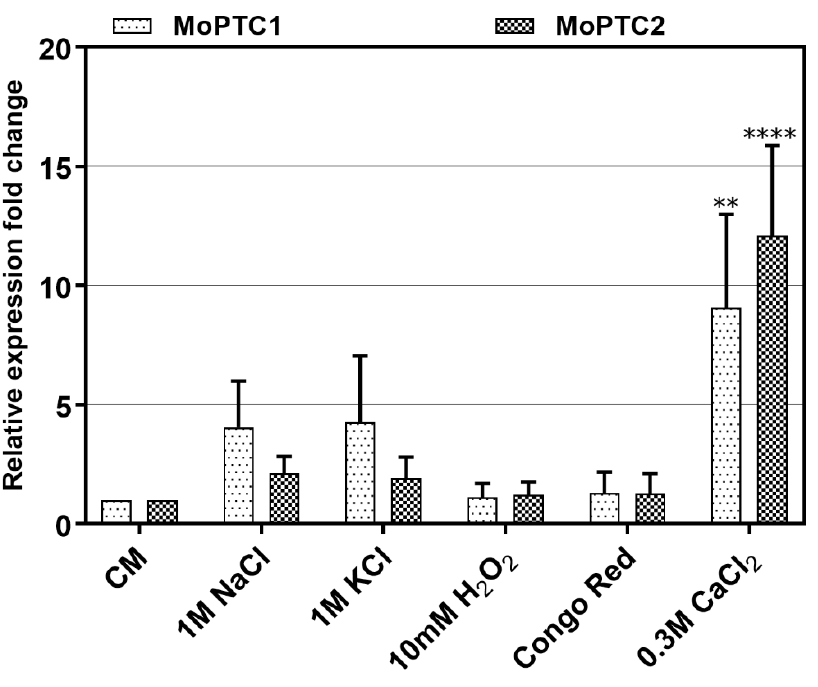
Figure 1. Transcript expression patterns of MoPTC1 and MoPTC2 in different stress-causing agents. In this assay, β -tubulin was used as the reference gene. The error bars represent the mean standard error from three independent replicates. The double asterisks indicate the adjusted p -value of 0.0013 and the quadruple asterisks show the adjusted p -value of <0.0001.